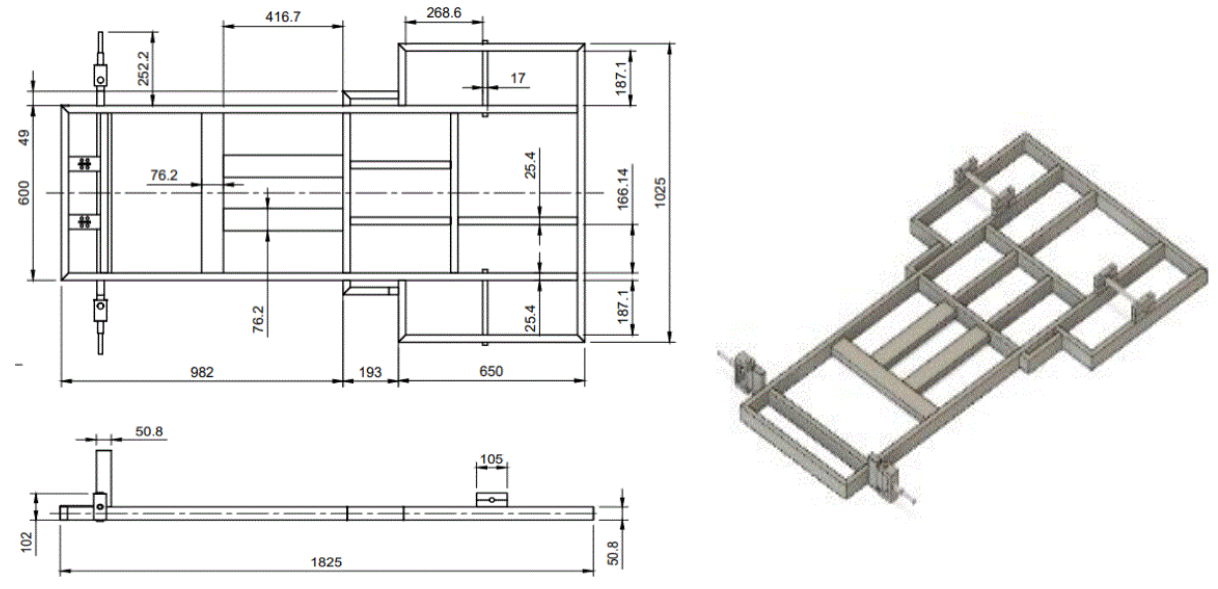
Figure 5: Design of SEM urban vehicle frames